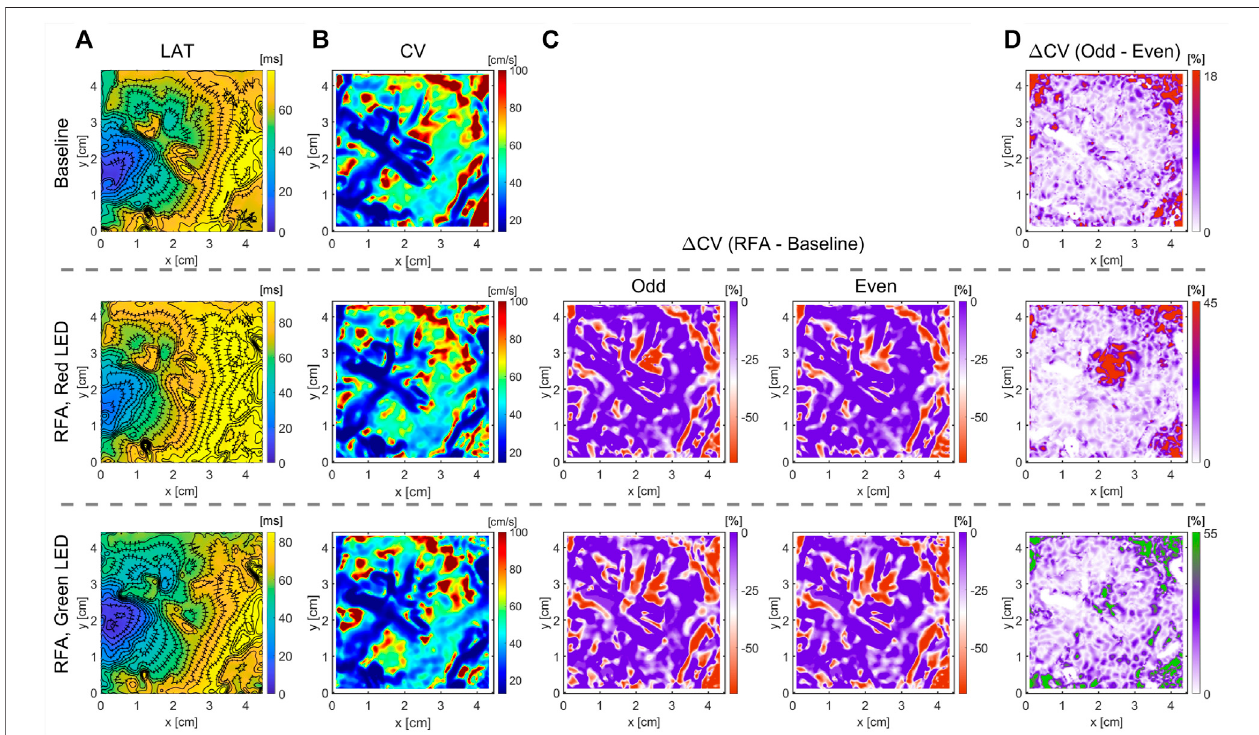
FIGURE 6 | Optical mapping on the LV ’ s endocardium in wedge preparation for quanti fi cation of RFA-created lesion. The RFA was performed on a highly trabeculated endocardium for 20 s, and power set to 40 W. Different light excitation bands were used, a green LED of 525 nm center wavelength and a red LED of 660 nm center wavelength, to measure optical APs emanating from the endocardial surface and deeper transmural layers. (A) Due to the highly heterogeneous endocardium ( Supplementary Figure S2 ), identi fi cation of the ablated area from LAT maps is non-trivial. (B,C) CV maps and the relative CV difference after and before the ablation do not clearly outline the ablated area, lacking characteristic CV slowing. (D) Relative difference in CV maps between subsequent beats (wavefront propagation), termed evenand odd, elicits theCVdifferences due toAPamplitudealternansintheablatedarea.GreenLEDlightilluminationofpenetration depthlimited to the endocardial surface layer, and the absence of alternans indicates a complete ablation of the surface layer. Illumination with a deep-red light band of deeper penetration depth enables measuring APs from deeper ventricular wall layers. The presence of CV alternans indicates the non-homogeneous or incomplete ablation acrosstheventricularwall( Supplementary Figure S2 ).The colorbar range inall fi gures wasset from the5th to95thpercentile,exceptfor Δ CV maps ’ upper boundary that was set to zero. Radius of 3 pixels (1.05 mm), in the CM, was used for CV calculation.